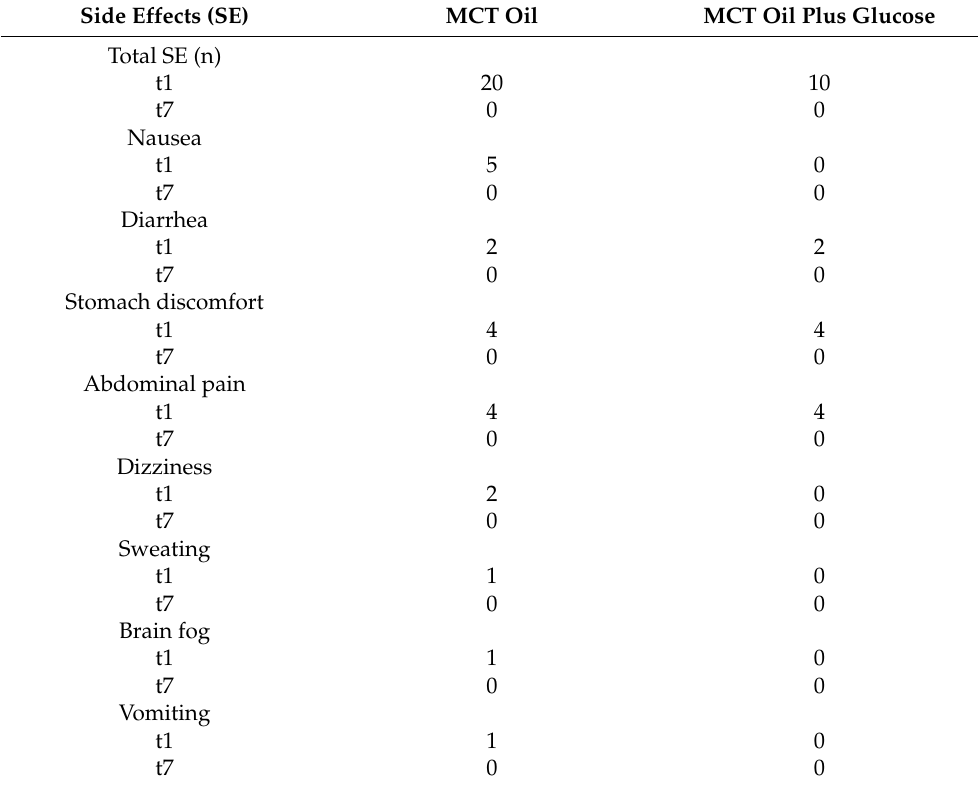
Table 2. Side effects between t1 and t7 ( n = 19) *. Side Effects